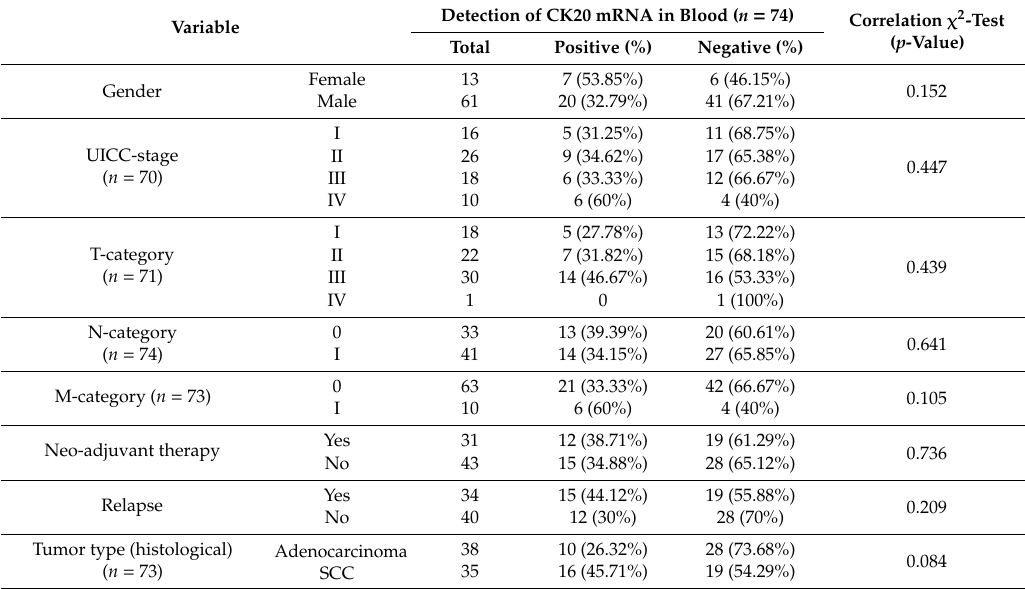
Table 3. Correlation between CK20 mRNA detection in blood of esophageal carcinoma patients and clinical parameters.